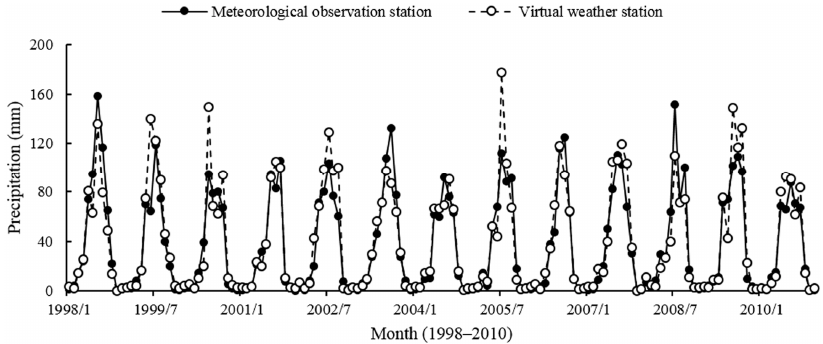
Figure 7. Basin monthly precipitation from meteorological observation station and virtual weather station.